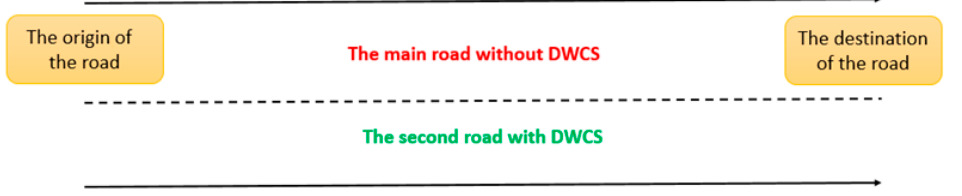
Figure 3. Structure of the road.